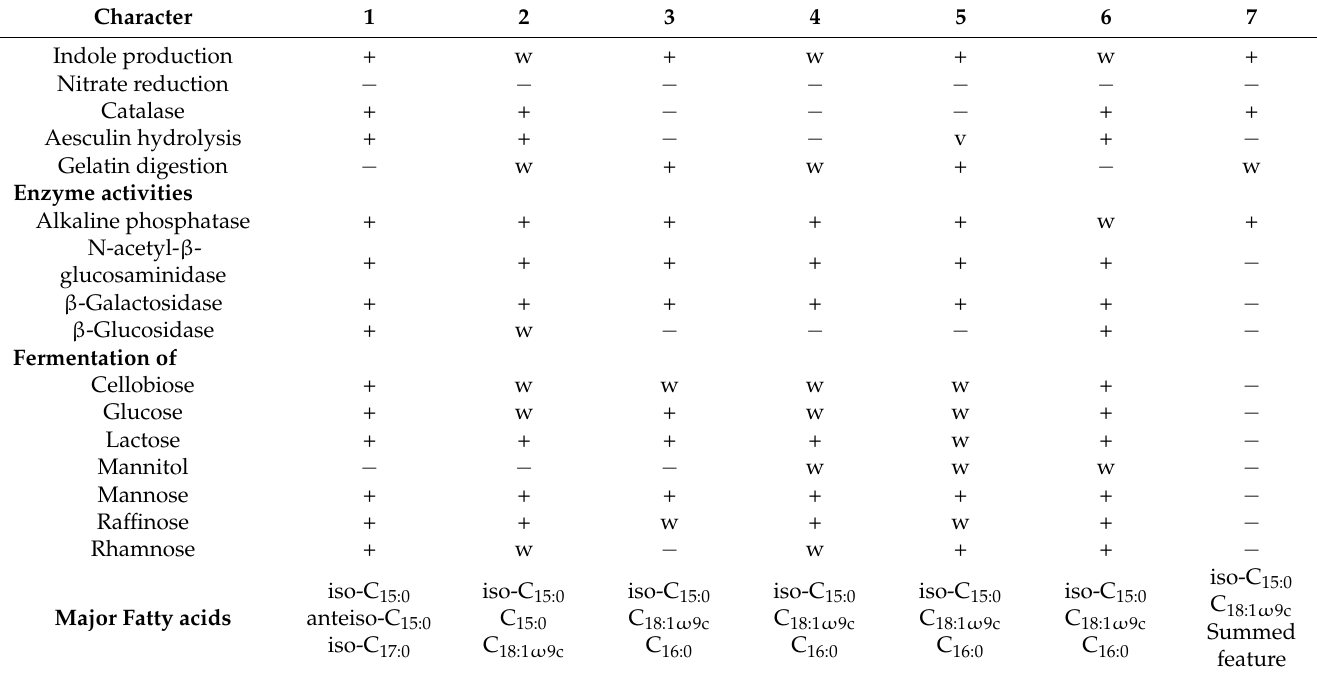
Table 1. Differential phenotypic features between strain kh20 T and closest related species